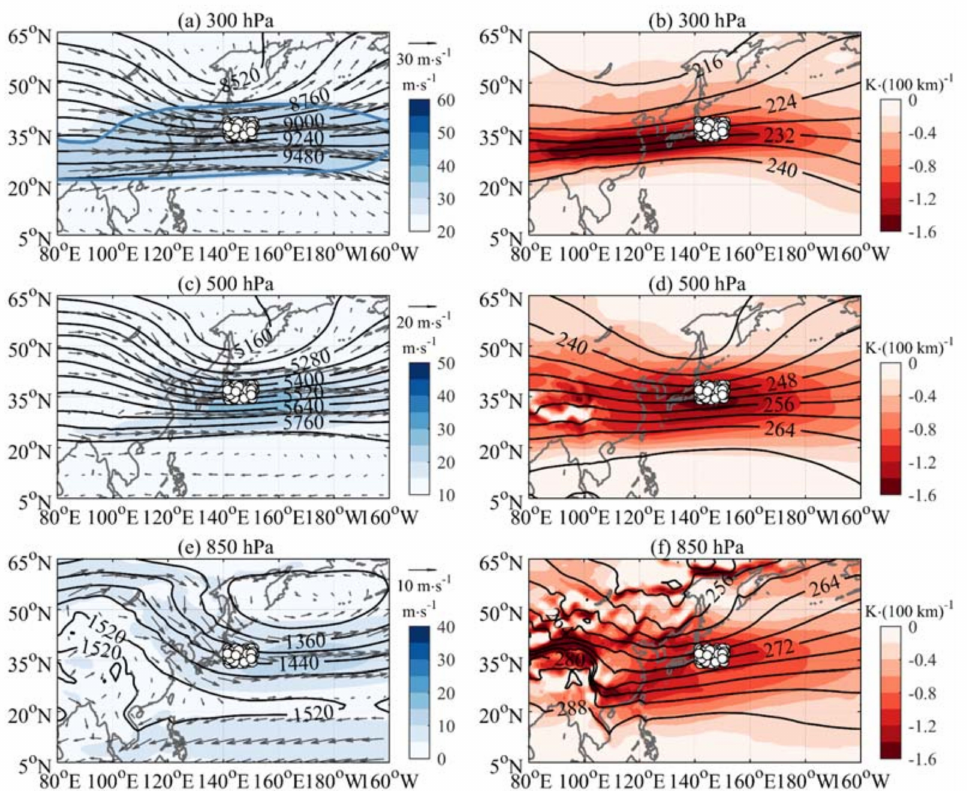
Figure 3. Composite background geopotential height (black contour, contour interval: 120 gpm at 300 hPa, 60 gpm at 500 hPa and 40 gpm at 850 hPa), the wind vectors (dark gray arrows) and the wind speed (blue shading) at the 300 hPa ( a ), 500 hPa ( c ), and 850 hPa ( e ) levels, respectively, and the temperature (the black contours, contour interval: 4 K) and horizontal meridional temperature gradient (red shading, unit: K/100 km) at the 300 hPa ( b ), 500 hPa ( d ), and 850 hPa ( f ) levels, respectively, on the cyclone onset day, based on the cyclones in the Northwest Pacific. The black circled white balls indicate the center of the cyclone at the sea